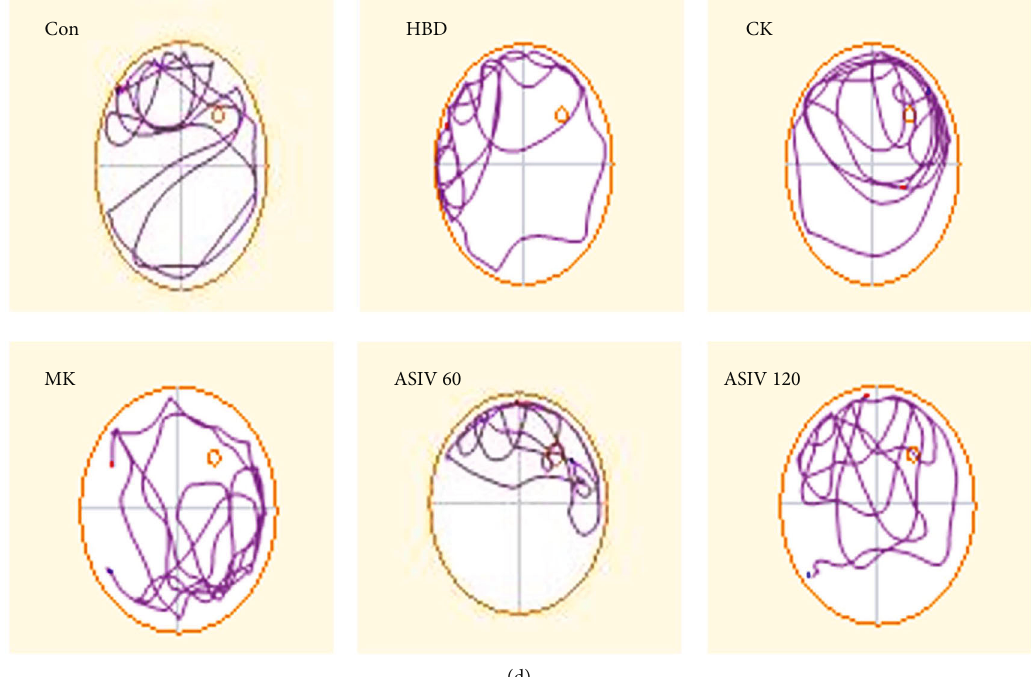
Figure 2: E ff ects of AS-IV and calpain-1 knockout on spatial learning and memory in mice with hypoxic brain injury. (a) The weight di ff erence of mice in each group was detected by a weight scale ( n = 6 ; F ð 5,30 Þ = 0 : 209 ). (b – d) The Morris water maze test was used to detect escape latency, path length, and times of passing through the target quadrant ( n = 6 ; latency, F ð 5,30 Þ = 3 : 952 ; path length, F ð 5,30 Þ = 4 : 515 ). Data are presented as the mean ± SD . ∗∗ P < 0 : 01 compared with the HBD group, # P < 0 : 05 compared with the ASIV 60mg/kg